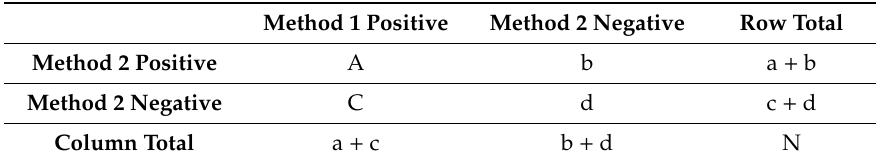
Table 2. McNemar